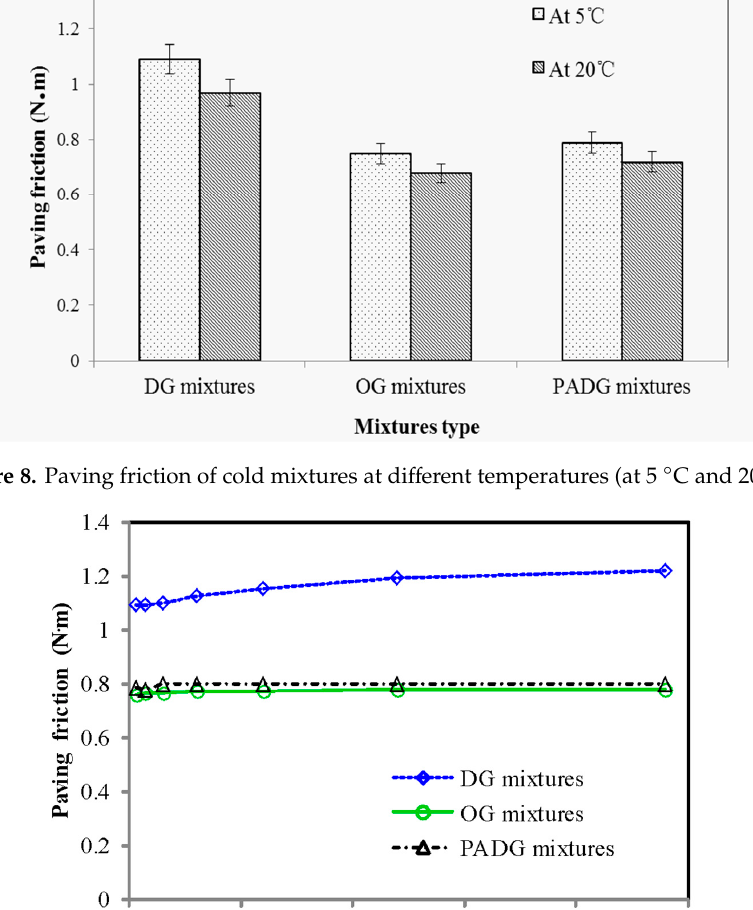
Figure 8. Paving friction of cold mixtures at different temperatures (at 5 °C and 20 °C).